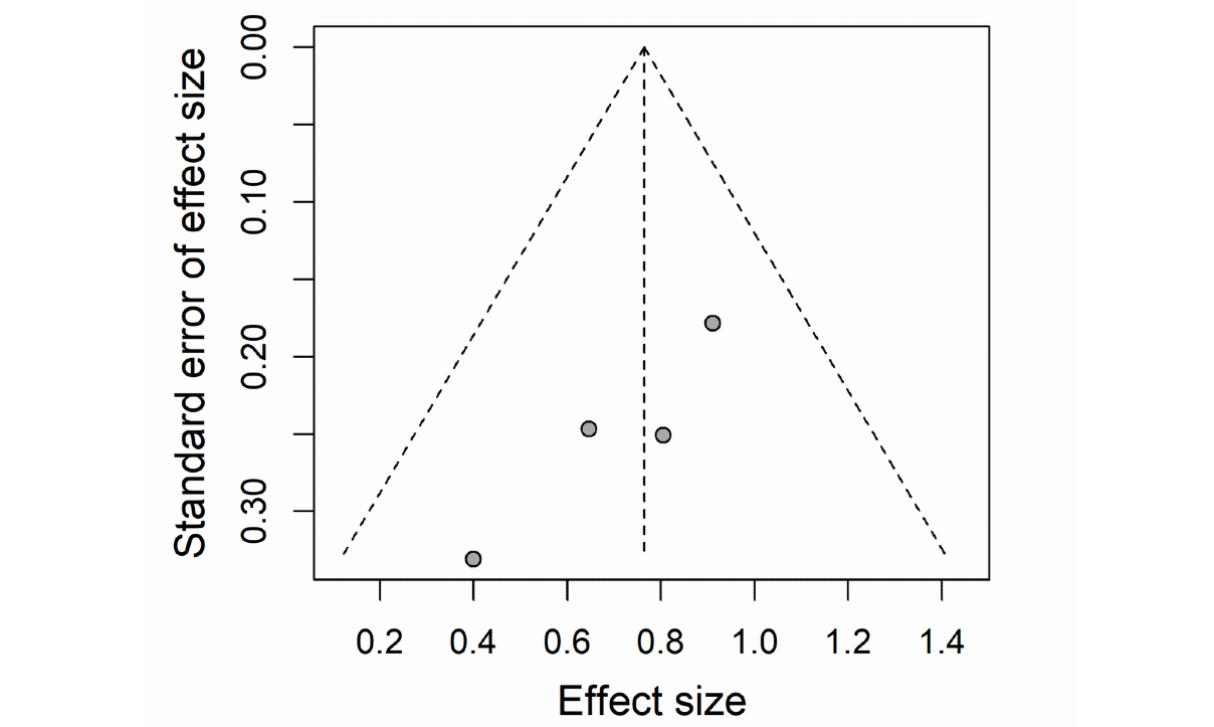
Figure 6. Funnel plot with pseudo 95% confidence limit for controlled trials.